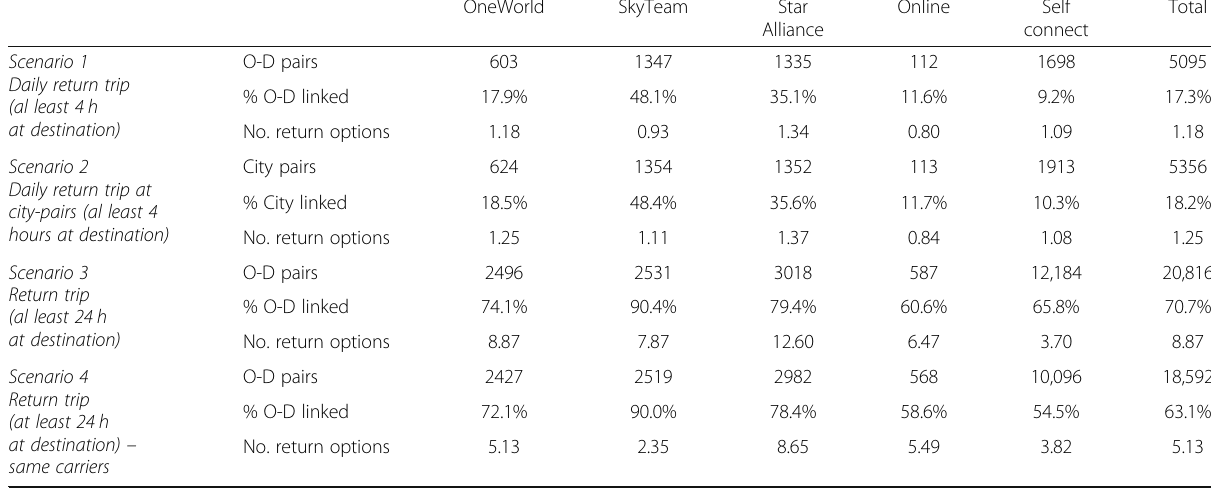
Table 5 Number of O-D pairs with return trips i) during the day with at least 4 h at destination, ii) during the day with at least 4 h at destination at city pairs, iii) with at least 24 h at destination and iv) with at least 24 h at destination and both the one-way and return trips operated by the same